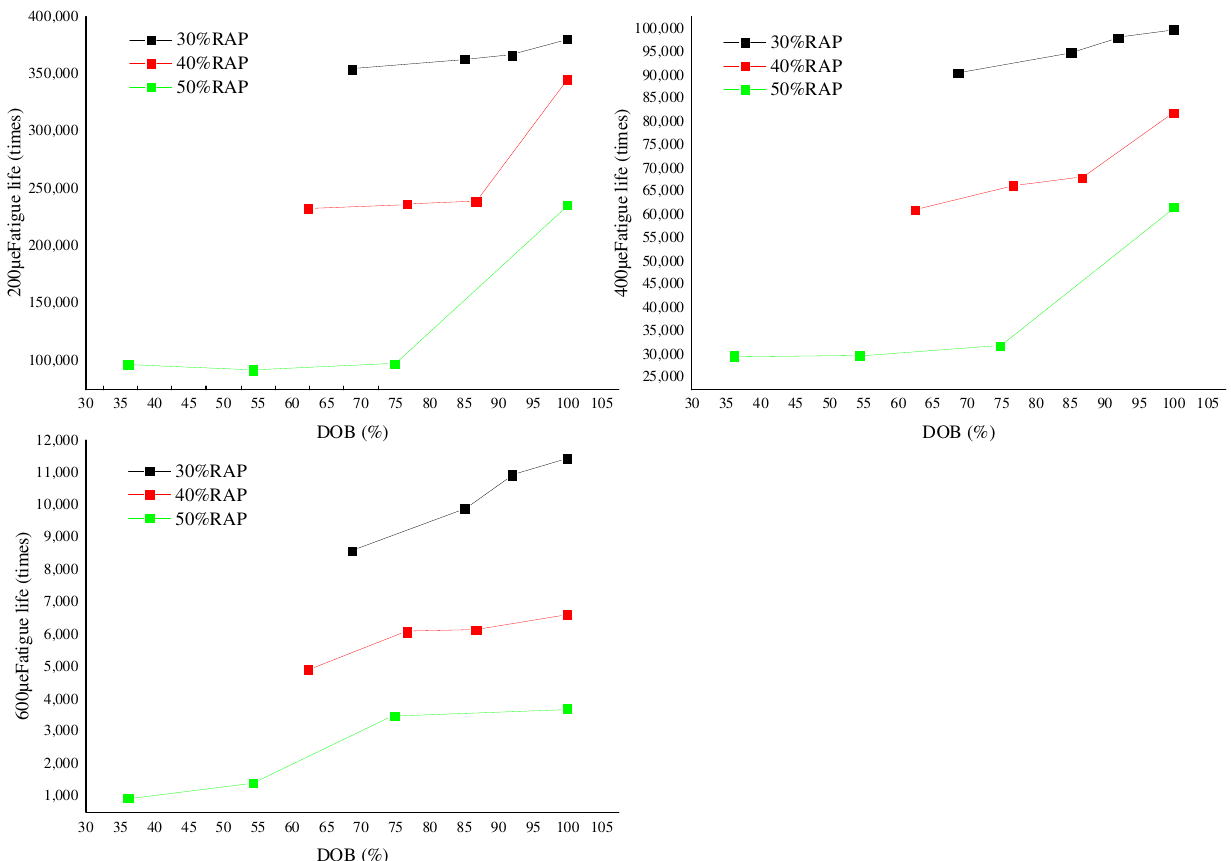
Figure 6. Variation of fatigue lifetimes with the variation of DOB under different RAP contents.